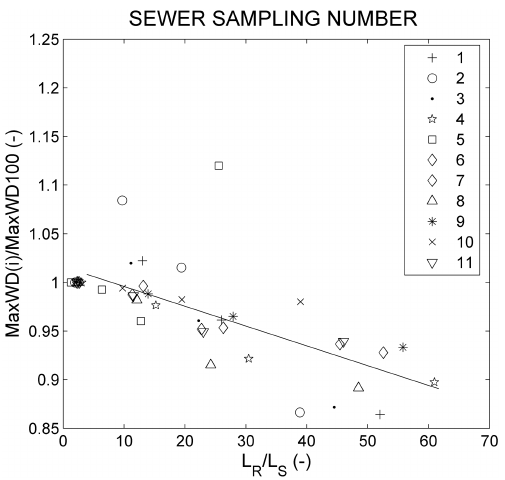
Figure 12. Normalised maximum water depths versus sewer sam- pling number ( L R / L S ) : results at the outlet of the 10 catchments and of the whole catchment (no.